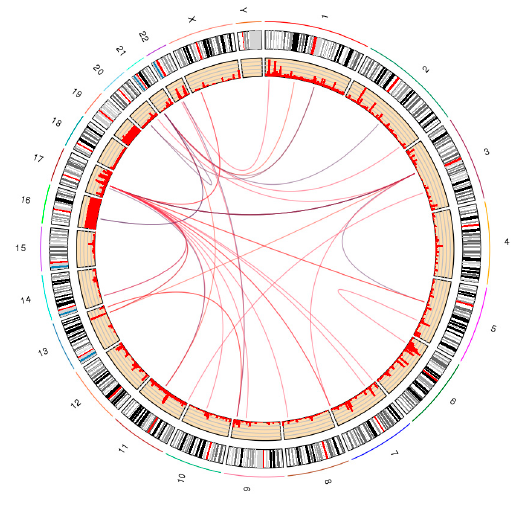
Figure A3. Circular view of chromatin interactions between different chromosomes from human cell line K562. Each curve represents one interaction.